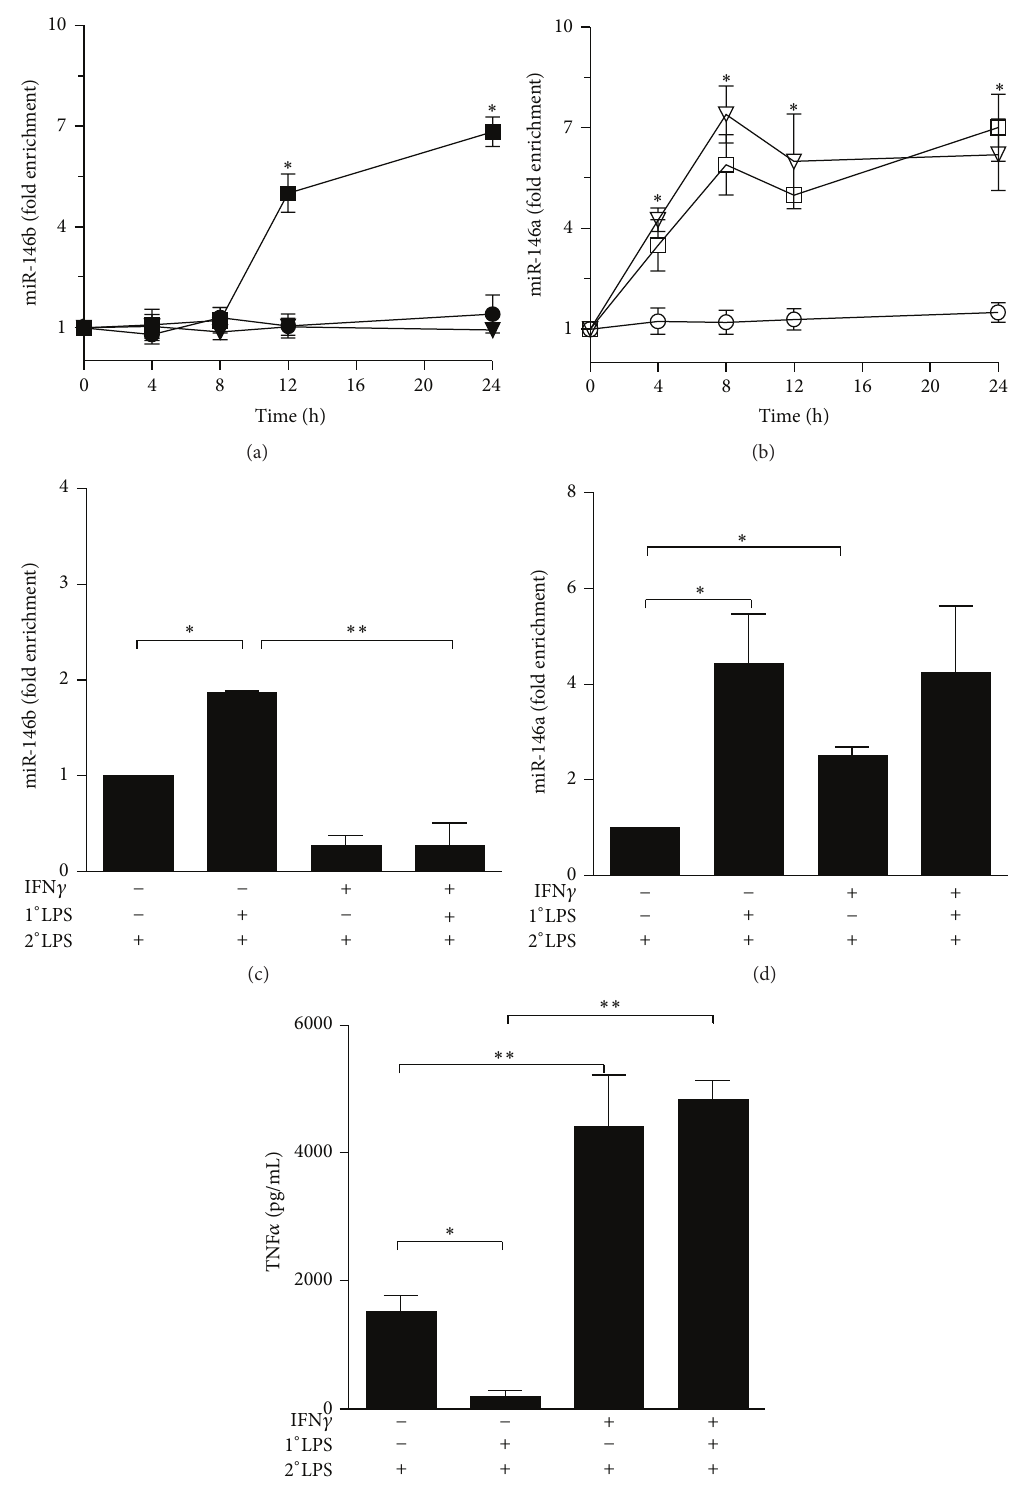
Figure 3: IFN 𝛾 inhibits the upregulation of miR-146b in tolerized monocytes . (a and b) Monocytes were cultured for the indicated times with 100ng/mL LPS (circle), 20 ng/mL IFN 𝛾 (square), or both stimuli (triangle). (a) MiR-146b and (b) miR-146a were quantified by qPCR. (c to e) Human purified monocytes pretreated or not with 10ng/mL IFN 𝛾 , primed with 0.1ng/mL LPS (1 ∘ LPS) for 18 h, and then challenged with 10ng/mL LPS (2 ∘ LPS). After 24 h stimulation levels of (c) miR-146b and (d) miR-146a were assayed by qPCR in triplicate samples, normalized relative to U6, and expressed as fold enrichment as compared to unstimulated samples. (e) TNF 𝛼 levels were measured by ELISA in cell-free supernatants. Results are expressed as mean ± SEM of three independent